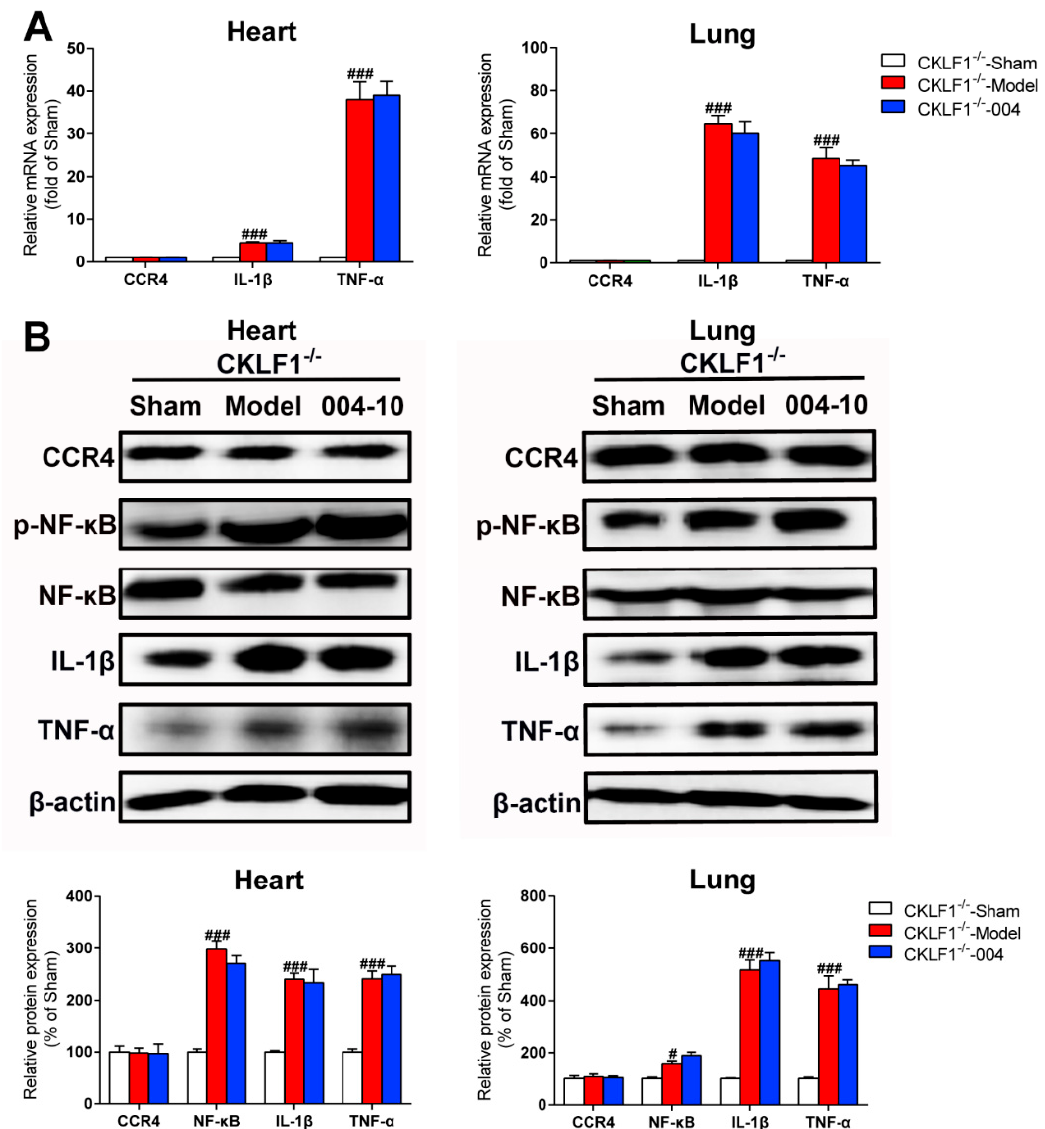
Figure 15. CKLF1 is necessary for IMM-H004 to suppress inflammation in heart and lung. ( A ) RT-PCR analysis for Effect of IMM-H004 on CCR4, p-NF- κ B, NF- κ B, IL-1 β , and TNF- α in the heart and lung of CKLF1 − / − rats. ( B ) Western blot analysis for the effect of IMM-H004 on CCR4, IL-1 β , and TNF- α in heart and lung of CKLF1 − / − rats. All the data are shown as the mean ± SD, a part of data are shown as the mean ± SD after normalization to the sham ( n = 6/group). # p < 0.05 vs. sham; ### p < 0.001 vs. sham.